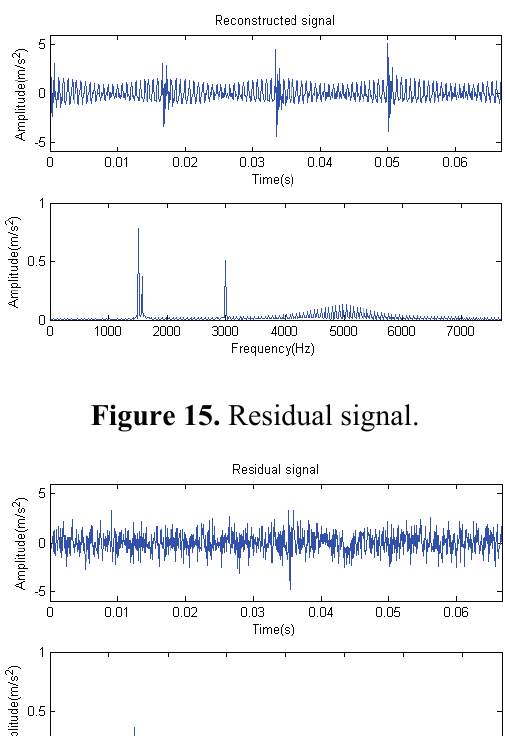
Figure 14. Reconstructed signal.